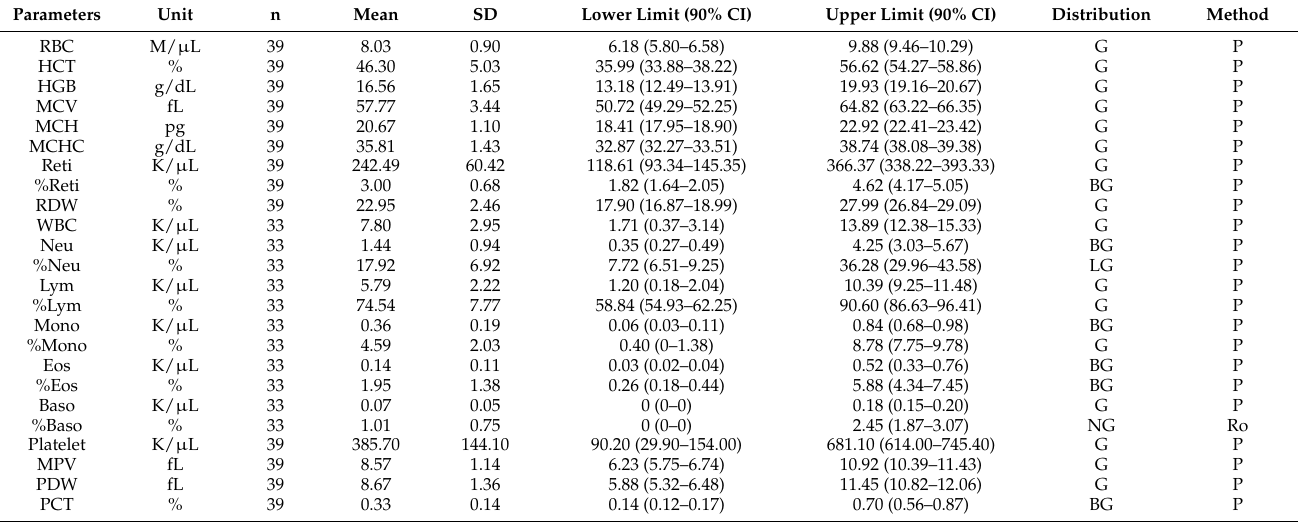
Table 2. Hematological reference intervals of pet sugar gliders in Taiwan.